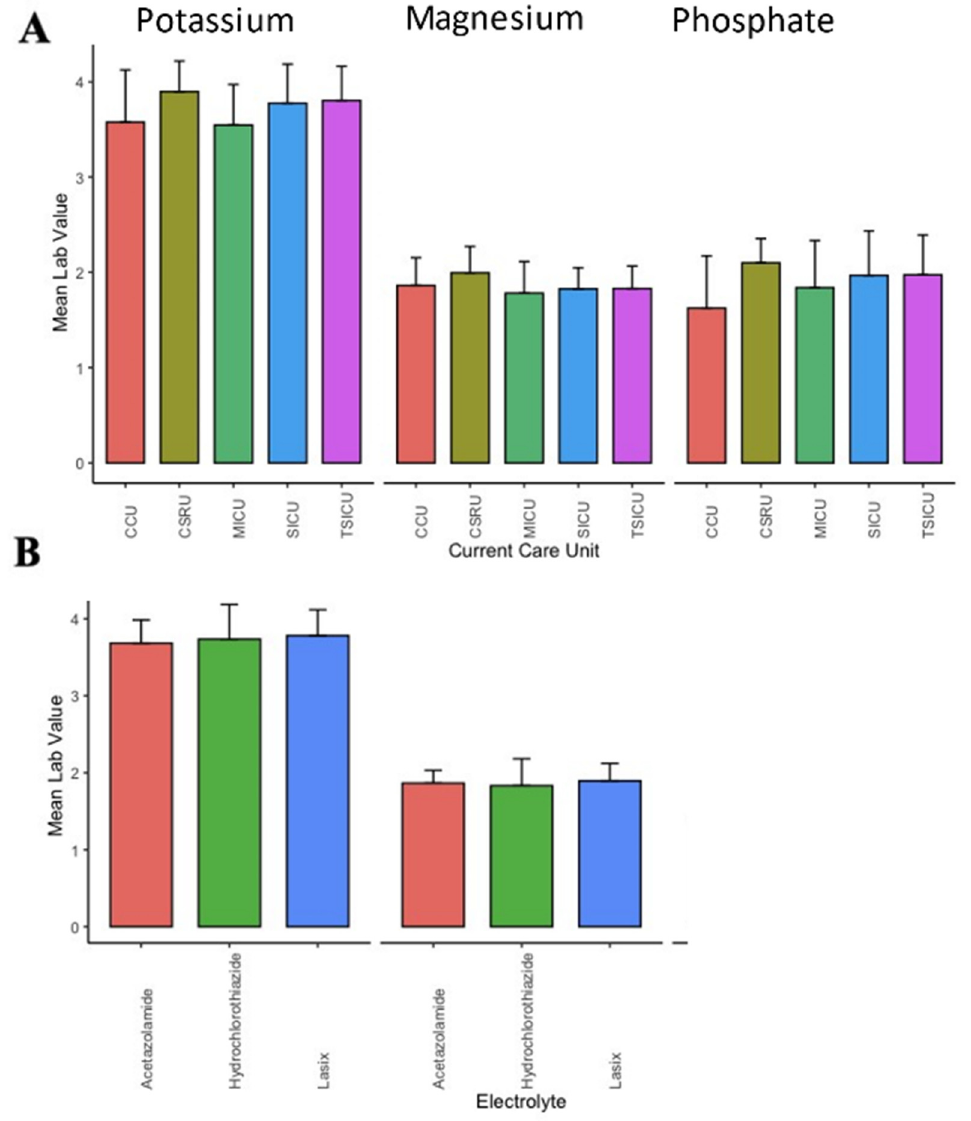
Figure 7. Significant differences in the threshold for replacement exist between different ICUs for potassium and magnesium but not phosphate ( A ). Being on a potassium-wasting diuretic (furosemide) or a potassium-sparring diuretic (acetazolamide) did not result in alteration of the threshold to replace potassium and magnesium ( B ).